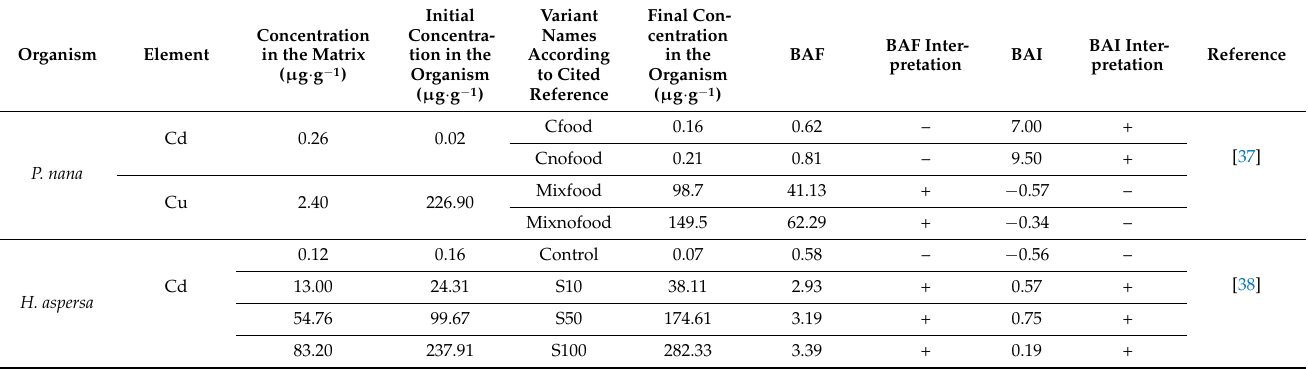
Table 3. Examples of the applicability of the BAI to organisms other than Hermetia illucens